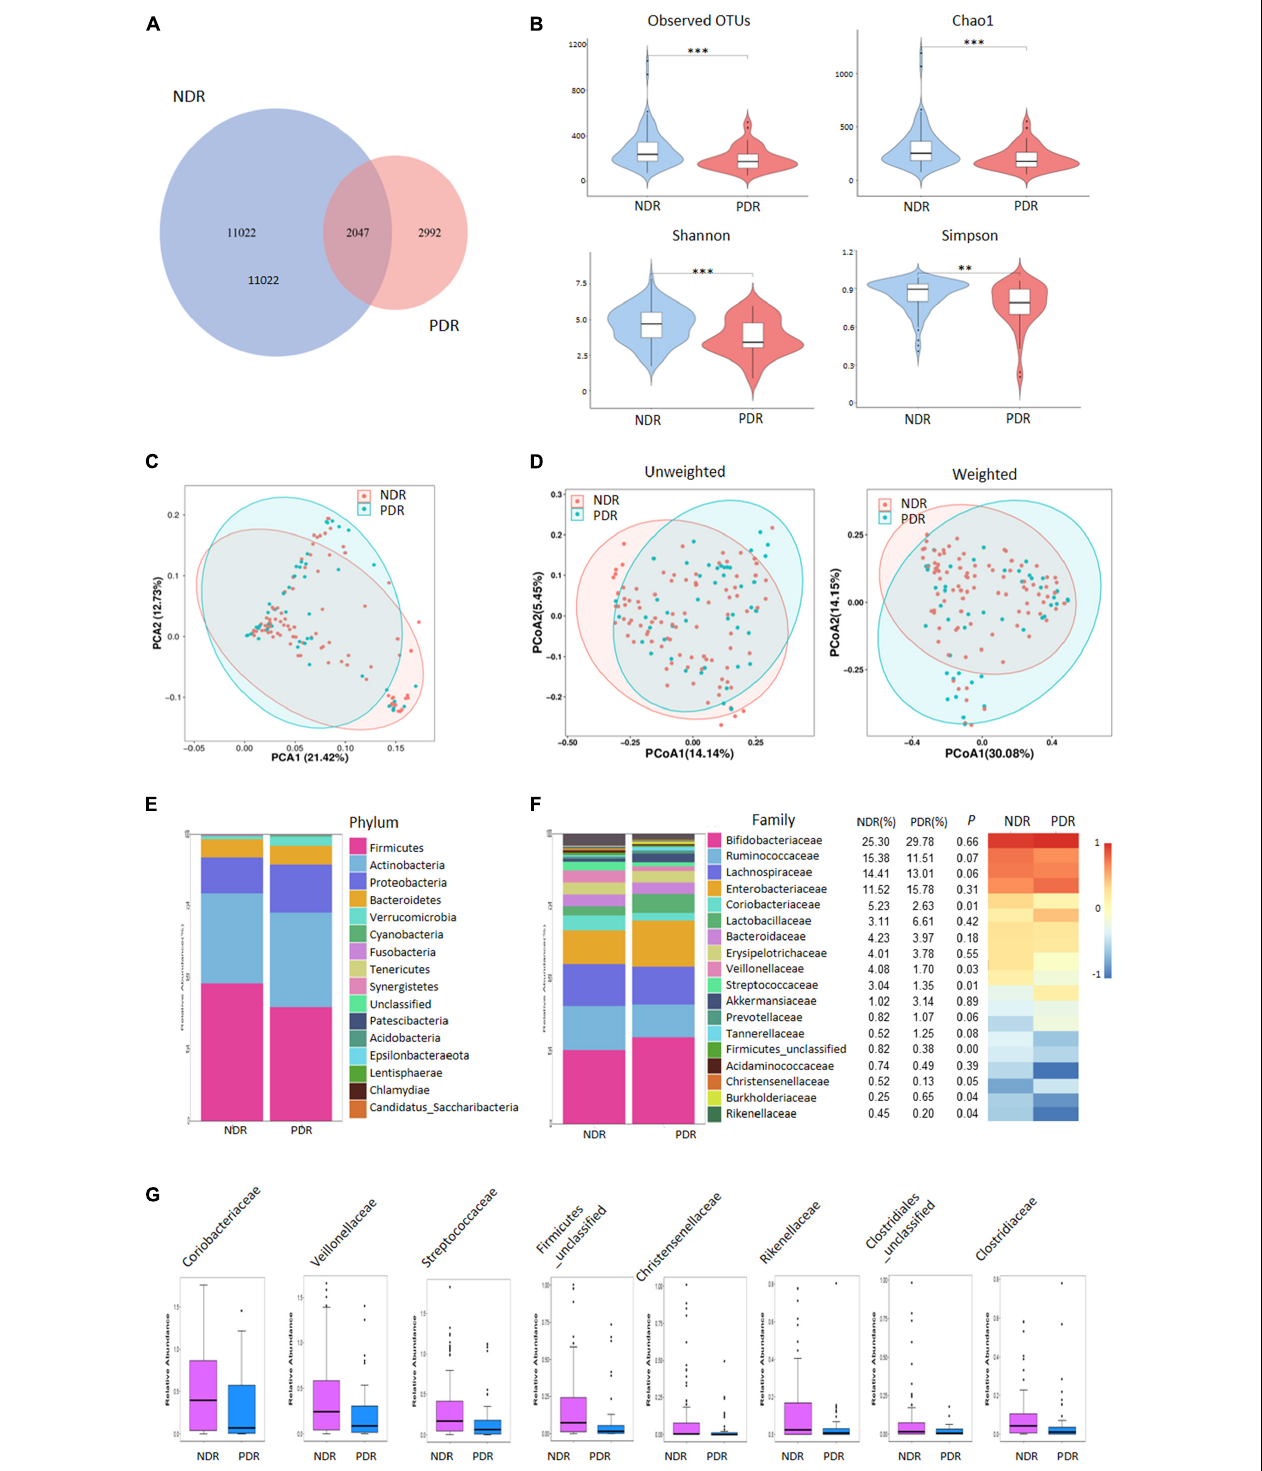
FIGURE 1 | Gut microbiome diversity and structure comparison. (A) The OTUs in the two groups. (B) Alpha diversity comparison between the two groups. (C) PCA analysis based on the relative abundance of operational taxonomic units. (D) Unweighted/weighted Unifrac the score PCoA plot. (E) Component proportion of bacteria phylum in the two groups. (F) The comparison of bacteria at family level. (G) TOP8-altered bacteria at family level. ∗∗∗ p < 0.001; ∗∗ p < 0.01; ∗ p < 0.05; PDR, proliferative diabetic retinopathy; NDR, diabetic patients without retinopathy; OTUs, operational taxonomic units; PCA, principal component analysis; PCoA, plot of principal coordinate